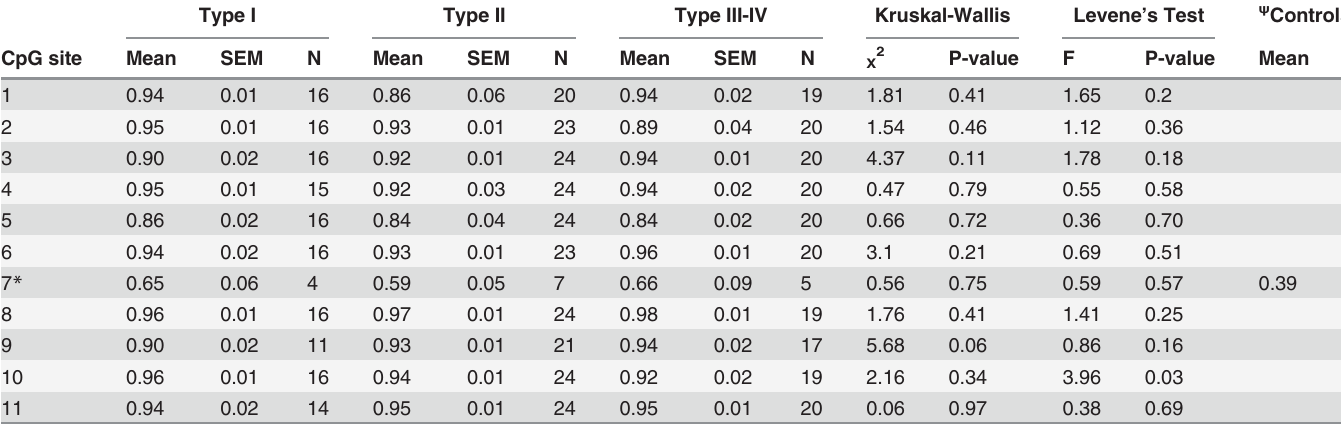
Table 5. Methylation levels (%) of CpG sites in a region located 1735 – 1398 bp upstream of CDK2AP1